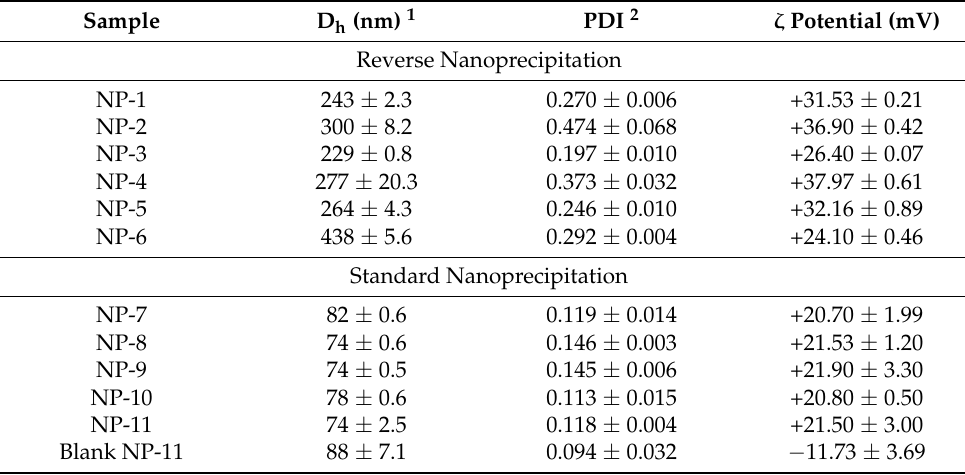
Table 1. Physicochemical properties of MH-b-PS@TMC